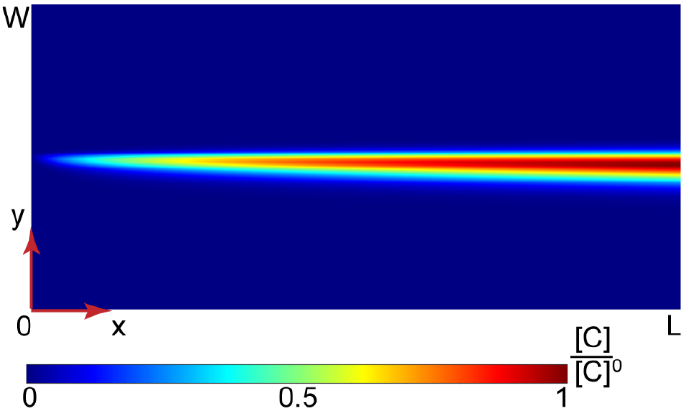
Figure 4. Numerical solution for the PAA-CTAB complexation in a Y-type microfluidic chip (L = 15 mm and W = 200 µ m). All the input flow rates are 10 µ L/min.